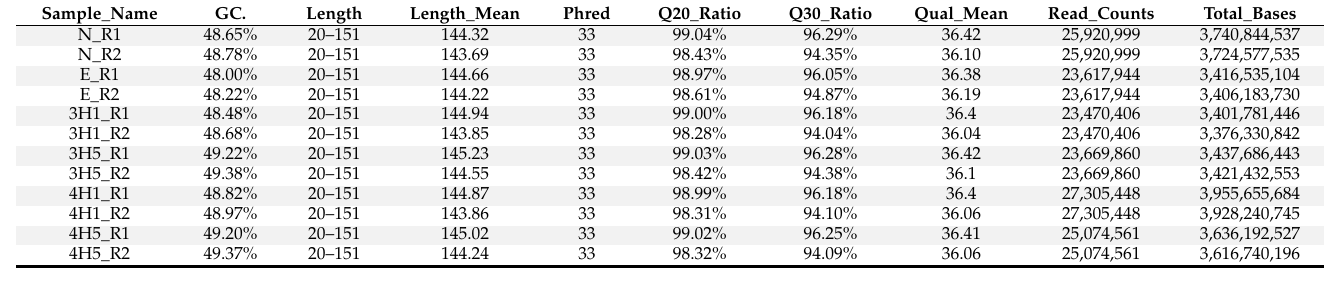
Table 1. Characteristics of the transcriptome of mouse brain astrocytes after excretory/secretory product or benzaldehyde treatment.